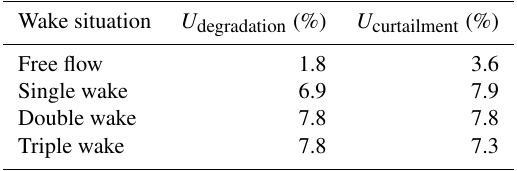
Table 4. Uncertainty U at quantity N of the first detection of un- derperformance with a certainty of 1 standard